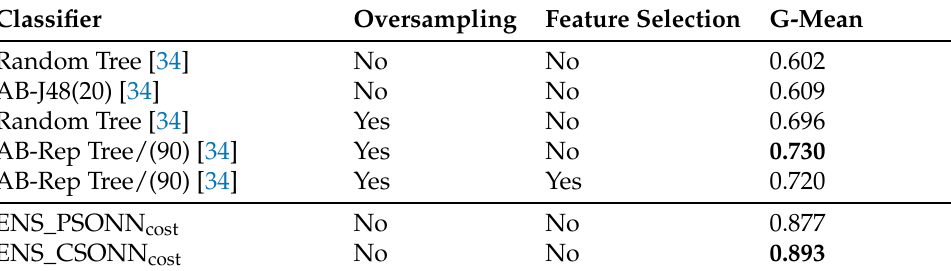
Table 16. The best results for the g-mean scores of the hybrid methods that were used in the related work compared to those of the two methods that are proposed in this work using the dataset of Spanish companies. The best g-mean result per classification approach is marked in boldface